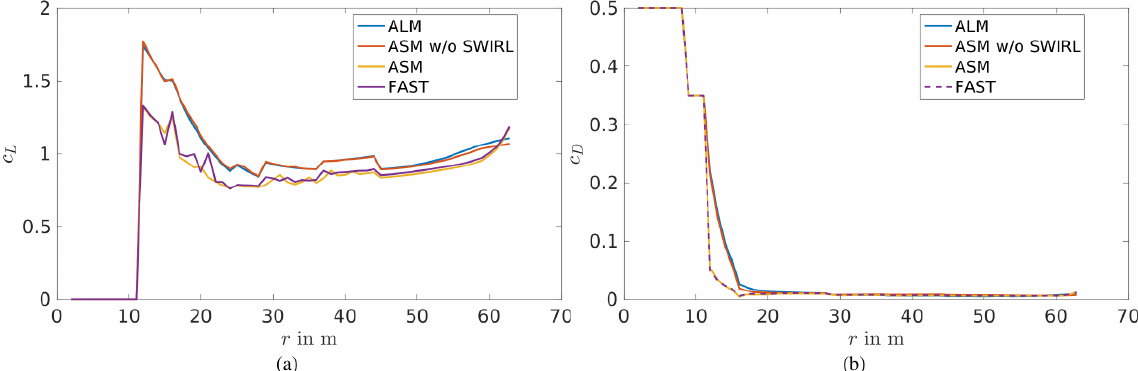
Figure A2. Lift (a) and drag (b) coefficient along the blade nodes in the laminar case of the NREL 5MW